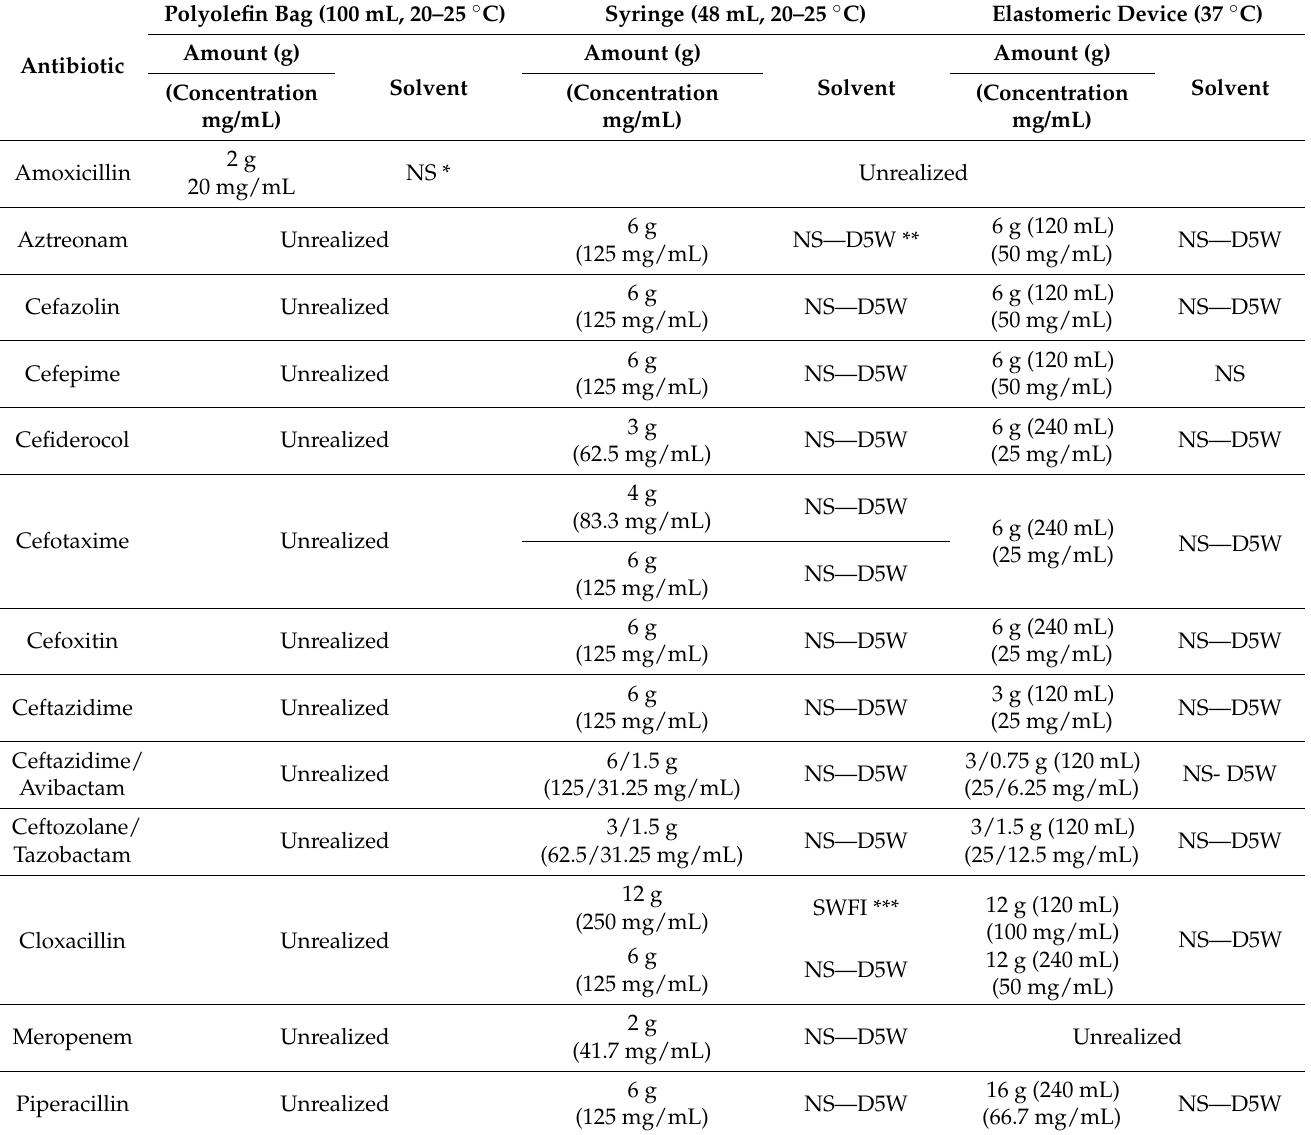
Table 5. Preparation of test